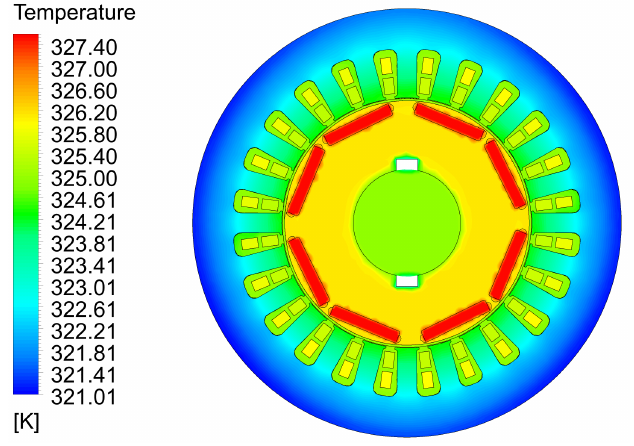
Figure 10. DSOF motor cross-section temperature field contour.